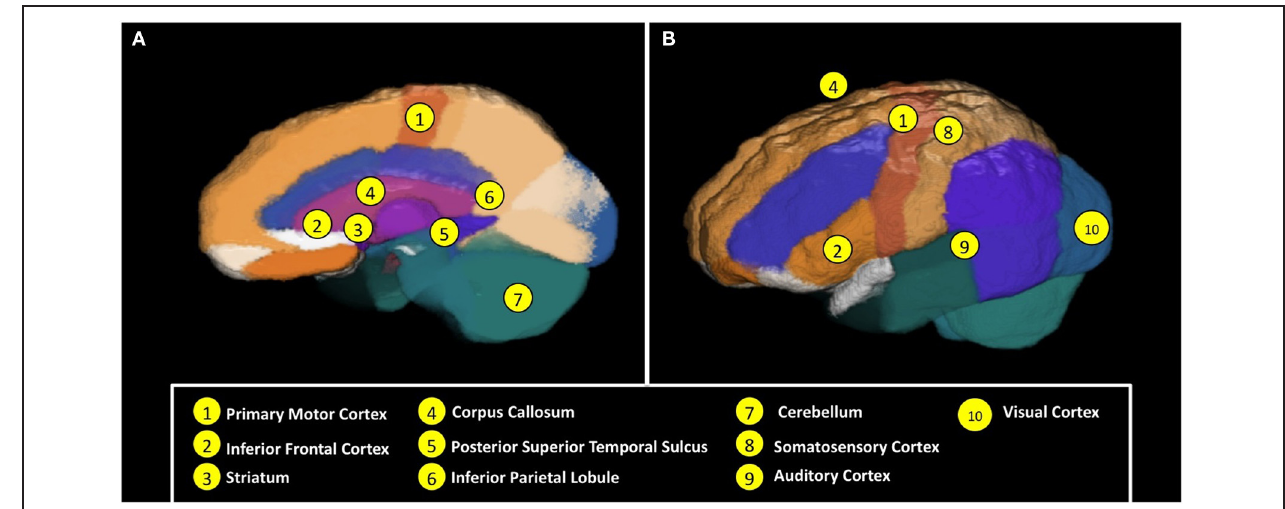
FIGURE 1 | Neural regions and mechanisms involved in (A) motor functioning and action perception, and (B) neural coordination and connectivity for sensorimotor and speech/language functioning. See